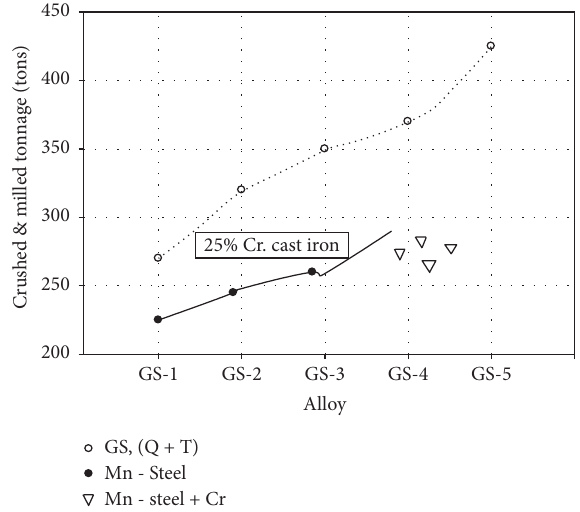
Figure 9: Hardness values of GS alloys as compared with 25% Cr cast iron.